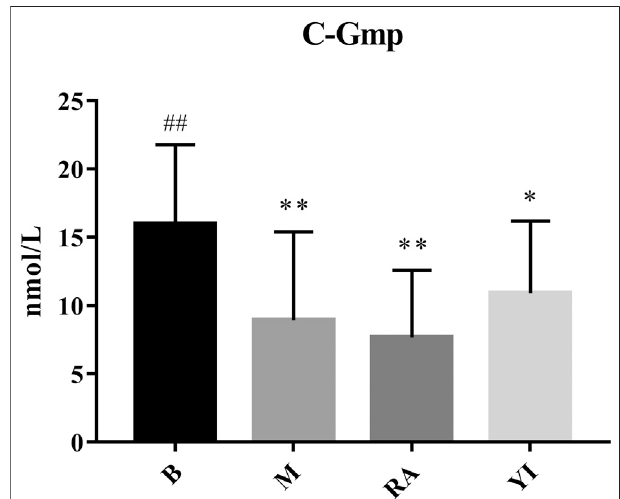
FIGURE10| Changesofserumc-AMPlevels.B,blankgroup;M,model group; RA, ULRA group; YI, YF group. Compared with B group, **: p < 0.01; Compared with M group, ##: p < 0.01. c-AMP, cyclic adenosine monophosphate; ULRA, unprocessed lateral root of Aconitum carmichaelii ; YF, Yinfupian.